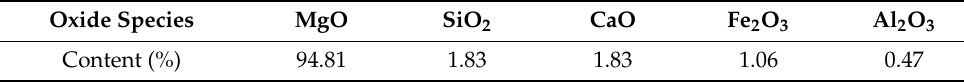
Table 1. The chemical composition of the dead burned magnesia powders.